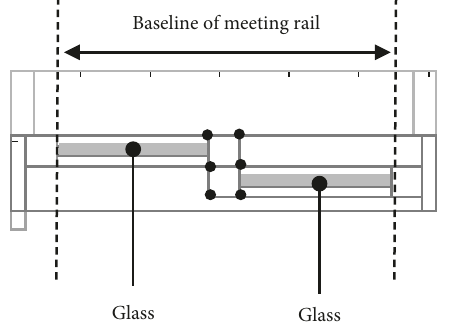
Figure 5: Cross-section generation algorithm (meeting rail).